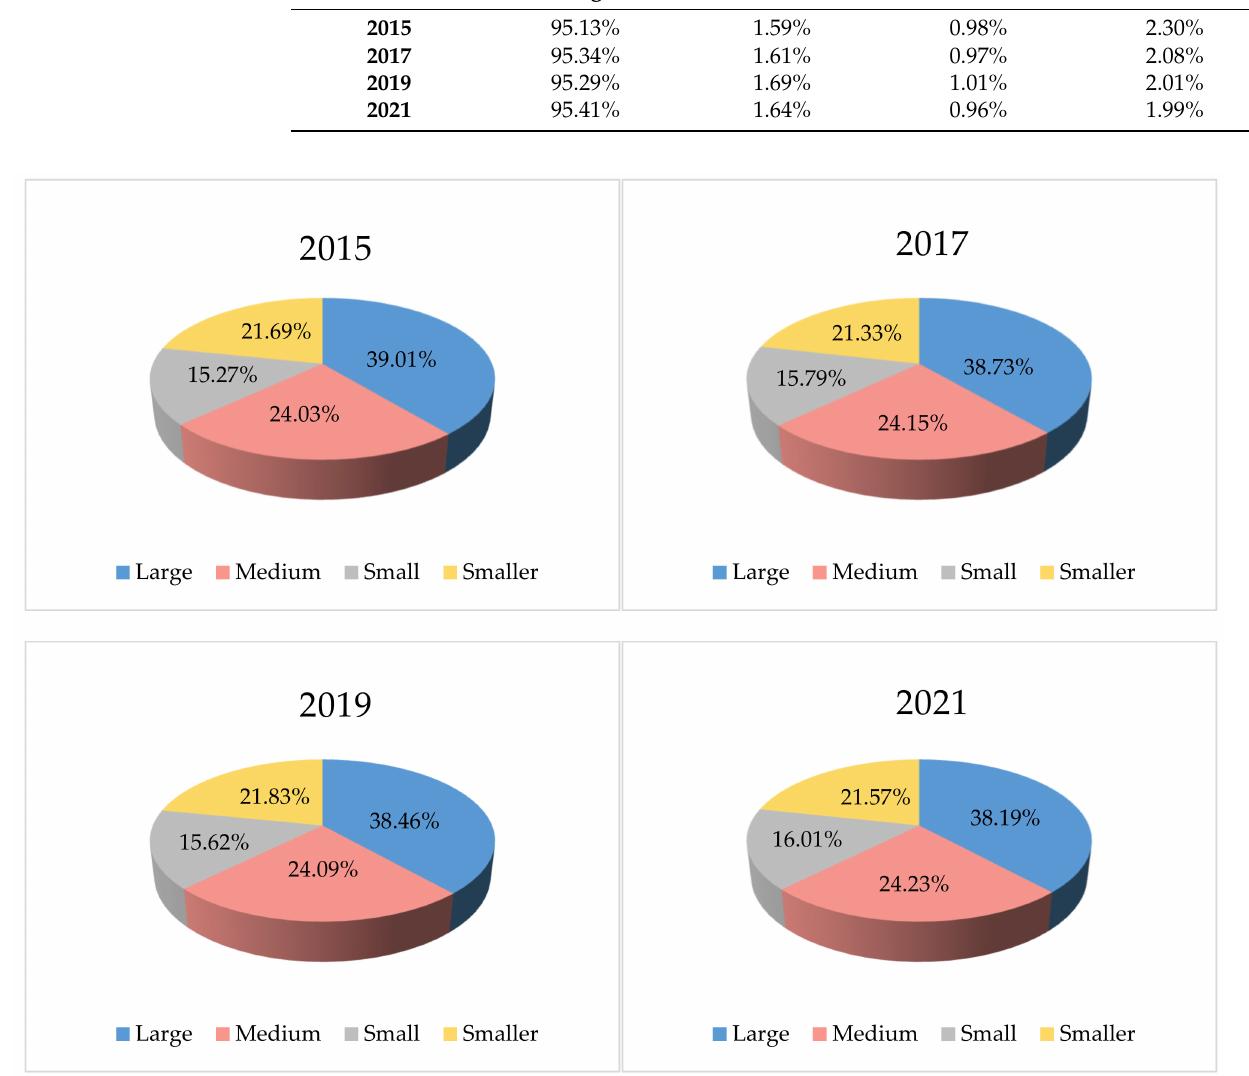
Figure 17. The changes to grassland areas at different